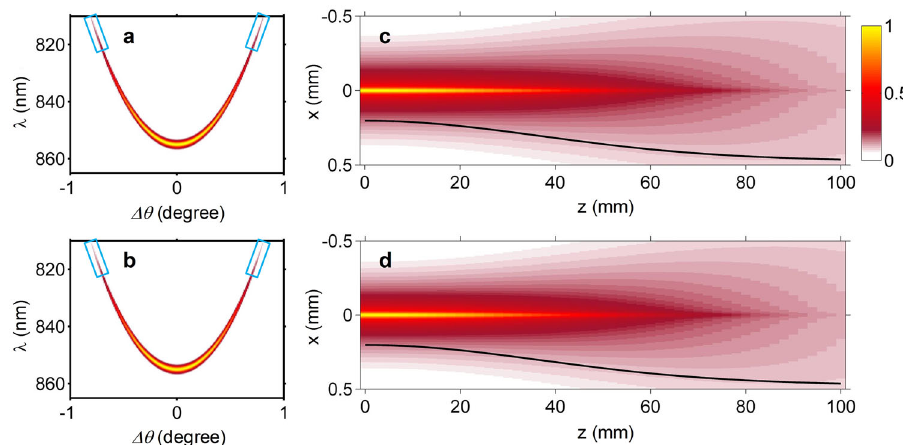
Fig. 4 Comparison between incident and ampli fi ed signal space-time (ST) wave packets. ST spectra of a incident and b ampli fi ed signal ST wave packets. Local-time integral intensity distributions during long-distance free propagation I ( x , z ) of c incident and d ampli fi ed signal ST wave packets. All fi gures share a normalized color-bar, and black curves in c and d are on-axis intensities.